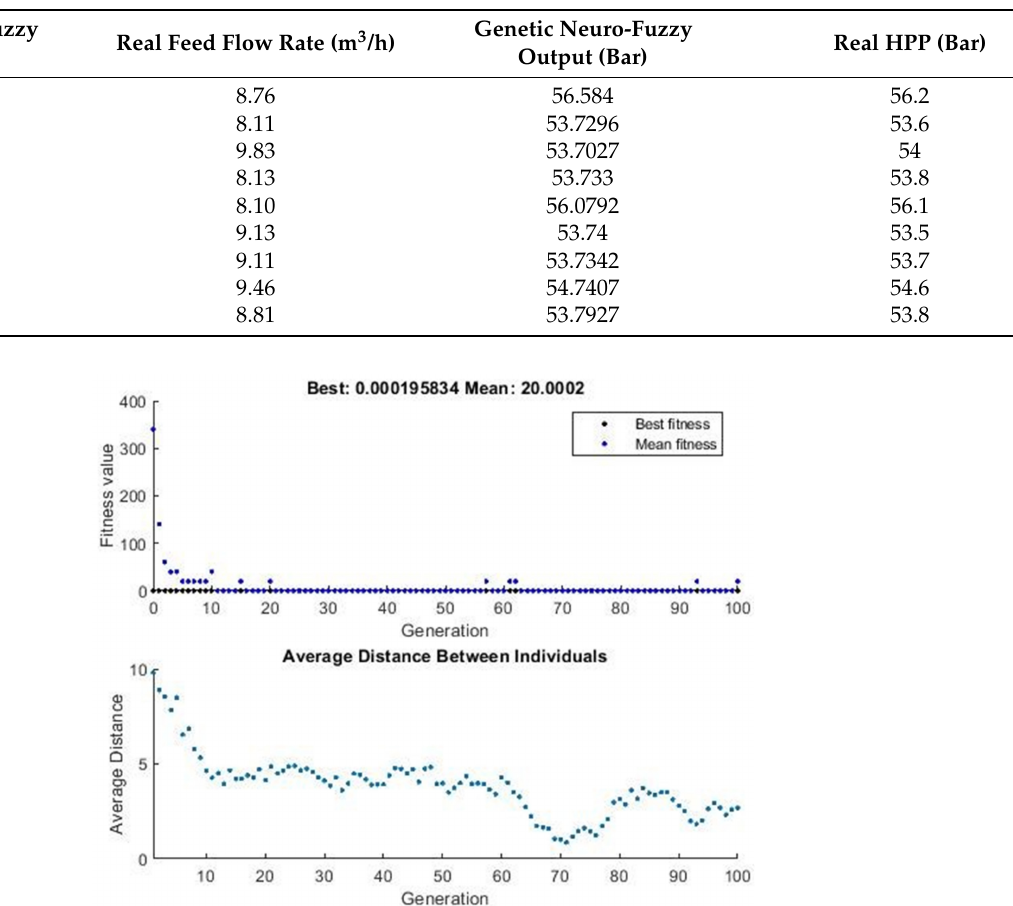
Figure 6. Average distances between individuals for HPP pressure as performance and evolution of the fitness value. Table 3. Comparison of results between outputs provided by GNF system and the real ones for HPP pressure (Bar) and Feed Flow rate (m 3 /h).